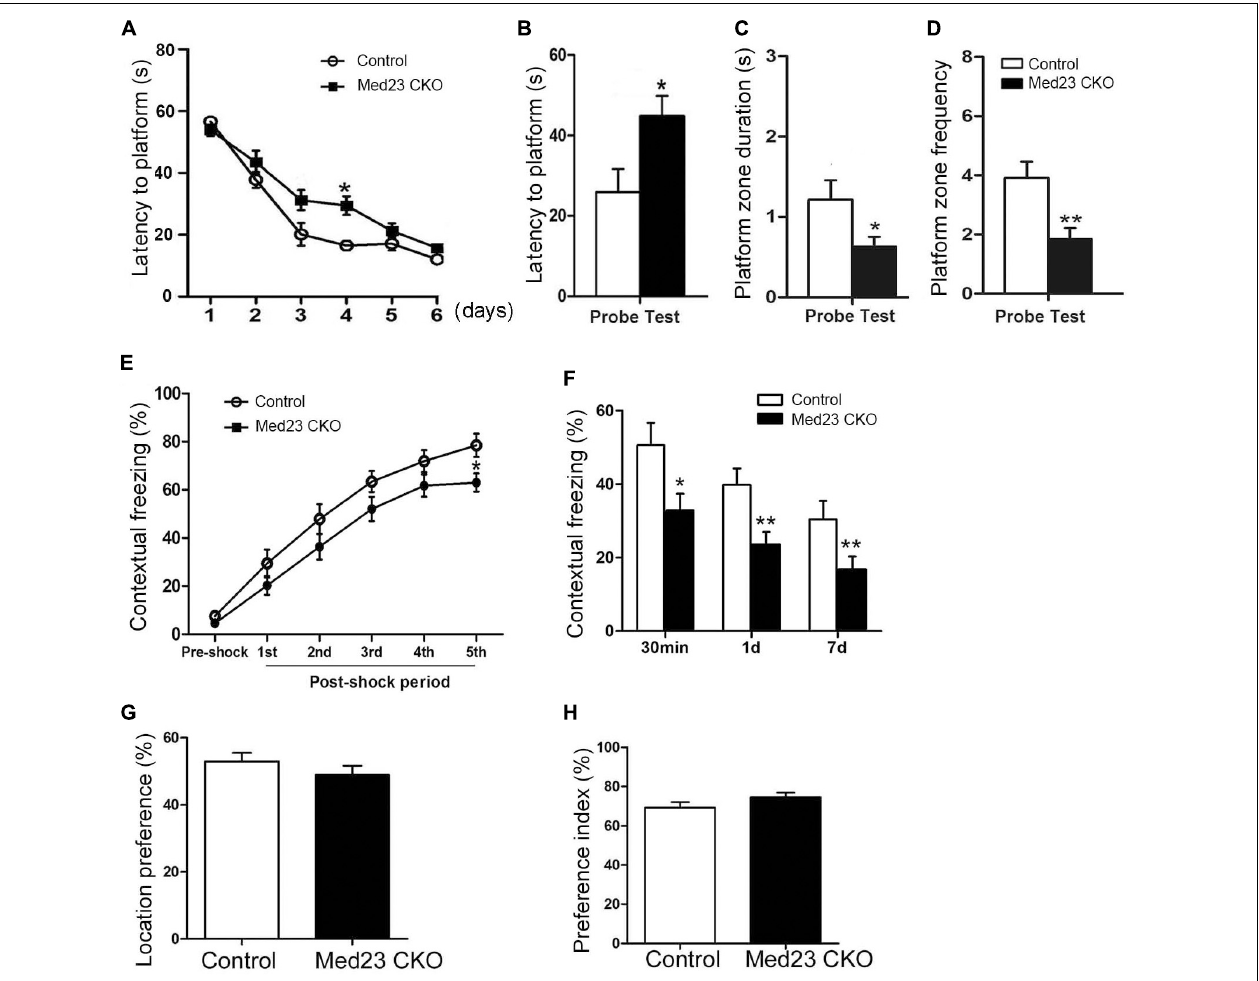
FIGURE 7 | Defective spatial memory and contextual fear memory in Med23 CKO mice. (A–D) Morris water maze test. Learning curve of Med23 CKO mice is similar to that of control mice in the probe training except at day 4 (A) , but in the probe test Med23 CKO mice show longer latency to platform (B) , less time spent in the platform zone (C) , and reduced frequency of crossing the platform (D) compared with controls. (E,F) Contextual fear memory test. Foot shocks provoke a significant decrease in freezing behavior at 5th shock in Med23 CKO mice during conditioning period (E) , and Med23 CKO mice also display reduced freezing behavior in the retrieval of contextual fear memory at all time points post conditioning compared with control mice (F) . (G,H) In the novel object recognition test, no differences in location index (G) and recognition index (H) are detected between Med23 CKO and control mice. N = 12 mice in control and 13 mice in Med23 CKO groups (A–F) ; n = 7 mice in control and 8 in Med23 CKO groups (G,H) . Data are plotted as the mean ± SEM. Student t -test, * p < 0.05, ** p <